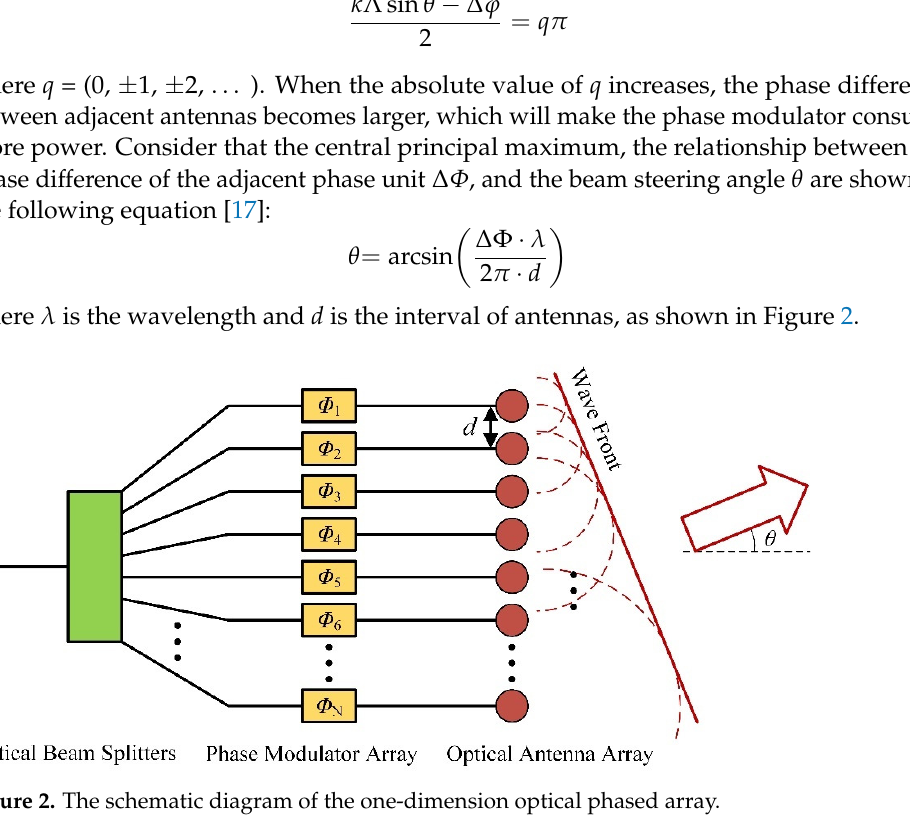
Figure 2. The schematic diagram of the one-dimension optical phased array.